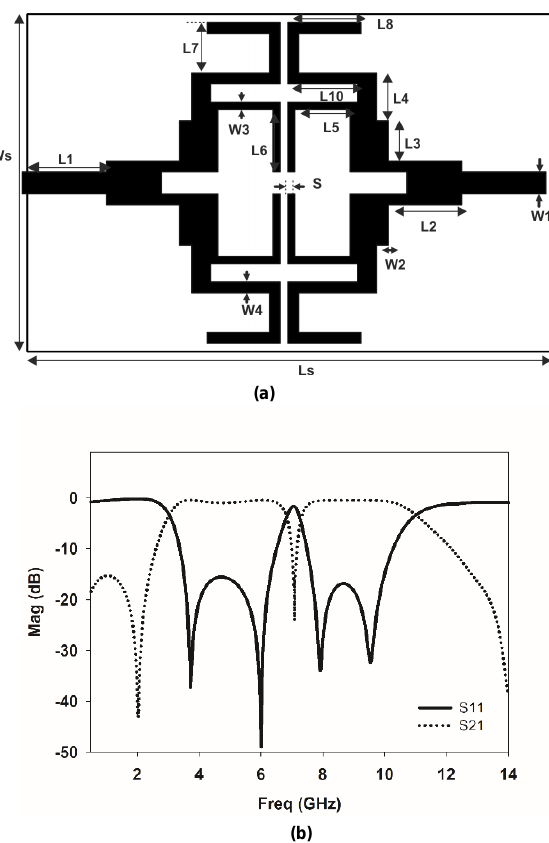
FIGURE 8. Geometry and simulation of the proposed UWB BPF with notched band: (a) Top and bottom view, (b)